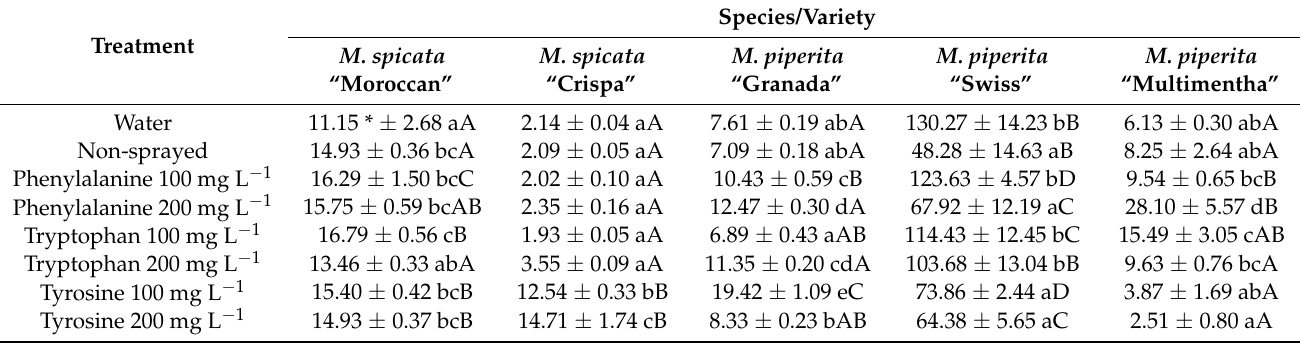
Table 3. Chlorogenic acid content in mints influenced by foliar application of amino acids, mg 100 g − 1 DM in 2017–2018.